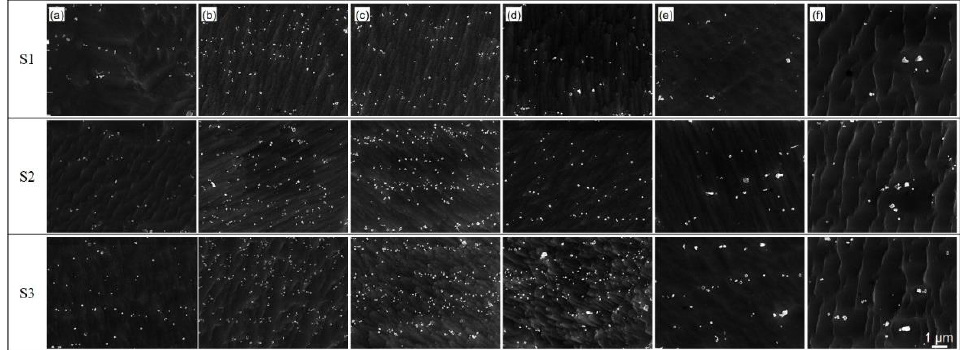
Figure 5. Typical micrographs corresponding to the precipitate distributions of samples extracted at different temperatures. ( a ) 850 °C; ( b ) 980 °C; ( c ) 1000 °C; ( d ) 1020 °C; ( e ) 1040 °C; ( f ) 1200 °C.